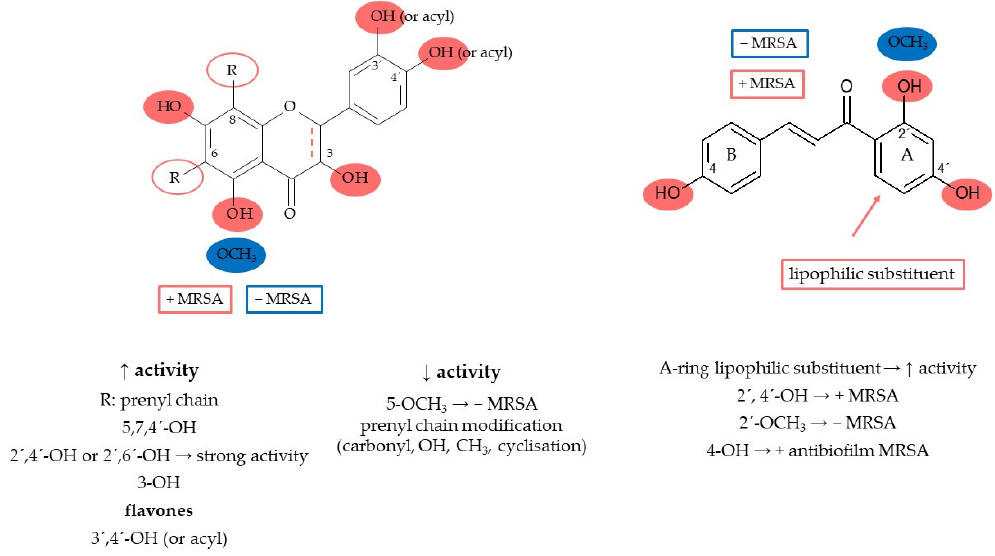
Figure 2. Flavonoids’ structure–activity relationship.